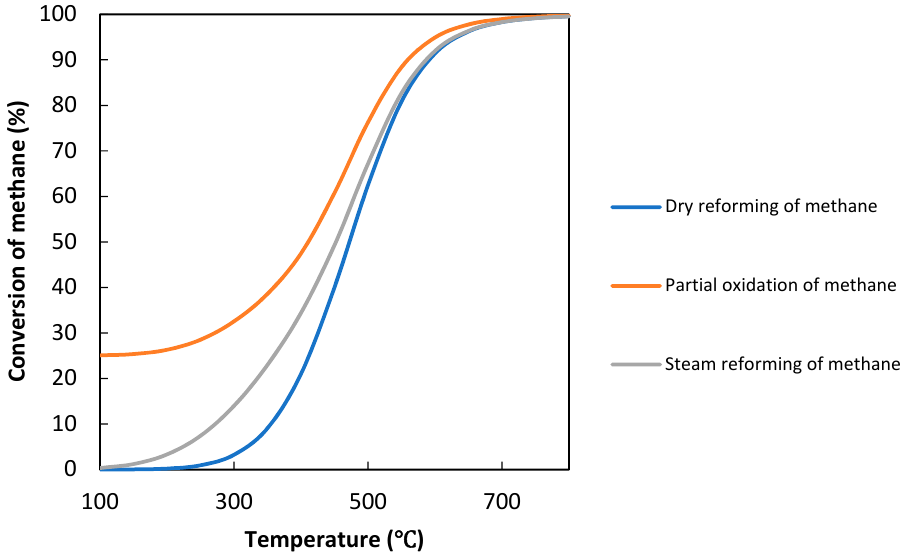
Figure 1. Calculated thermodynamic equilibrium of dry reforming of methane (blue line), partial oxidation of methane (using O 2 , orange line), and steam reforming of methane (gray line). Equation (1) was used to calculate the equilibrium for the steam reforming of methane. The input gas of methane and oxidant were both at 0.01 atm [7].